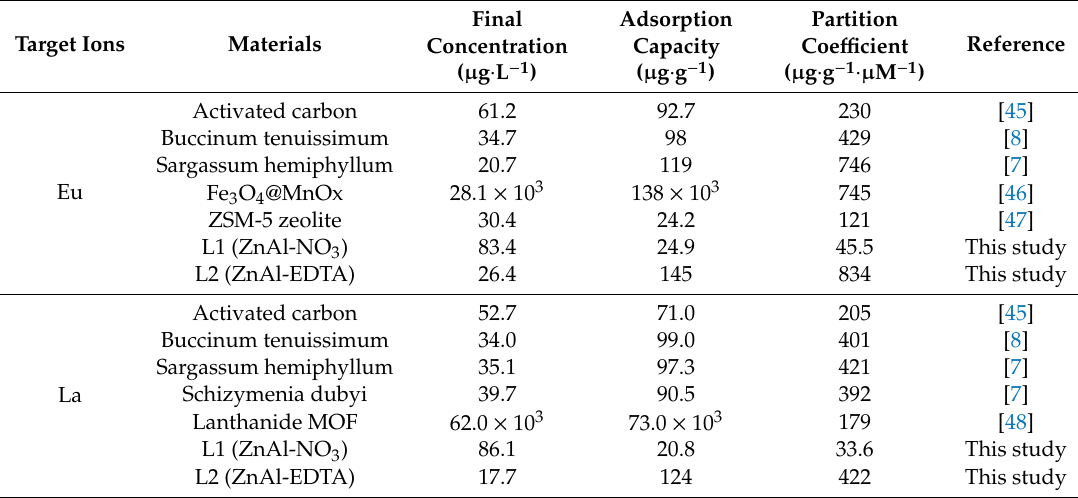
Table 6. The comparison of adsorption properties of various of